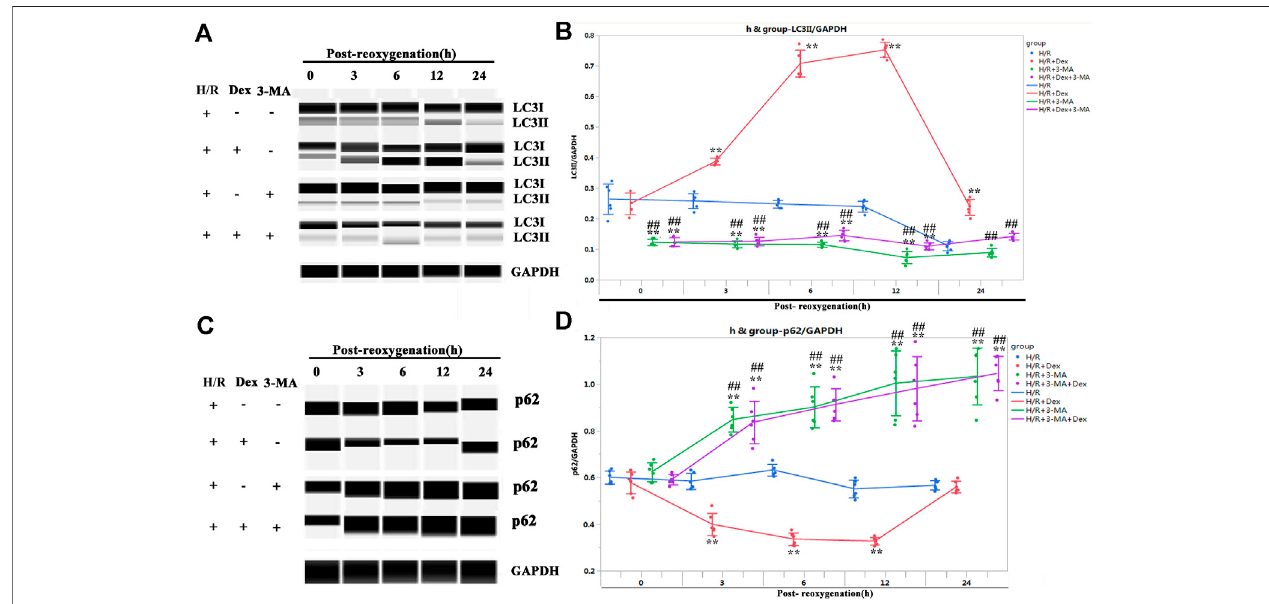
FIGURE3| Autophagyinhibitor (3-methyladenine,3-MA)blockedtheautophagy fl uxinducedbyDex. (A) Representative LC3IIWesblotsofiPSC-CMspretreated with Dex and 3-MA. (B) Quanti fi cation of the LC3II relative expression. N (cid:2) 6 replicates. (C) Representative p62 Wes blots of iPSC-CMs pretreated with Dex and 3-MA. (D) Quanti fi cation of the p62 relative expression. N (cid:2) 6 replicates. ** p < 0.01. vs. H/R; ## p < 0.01, vs. H/R +